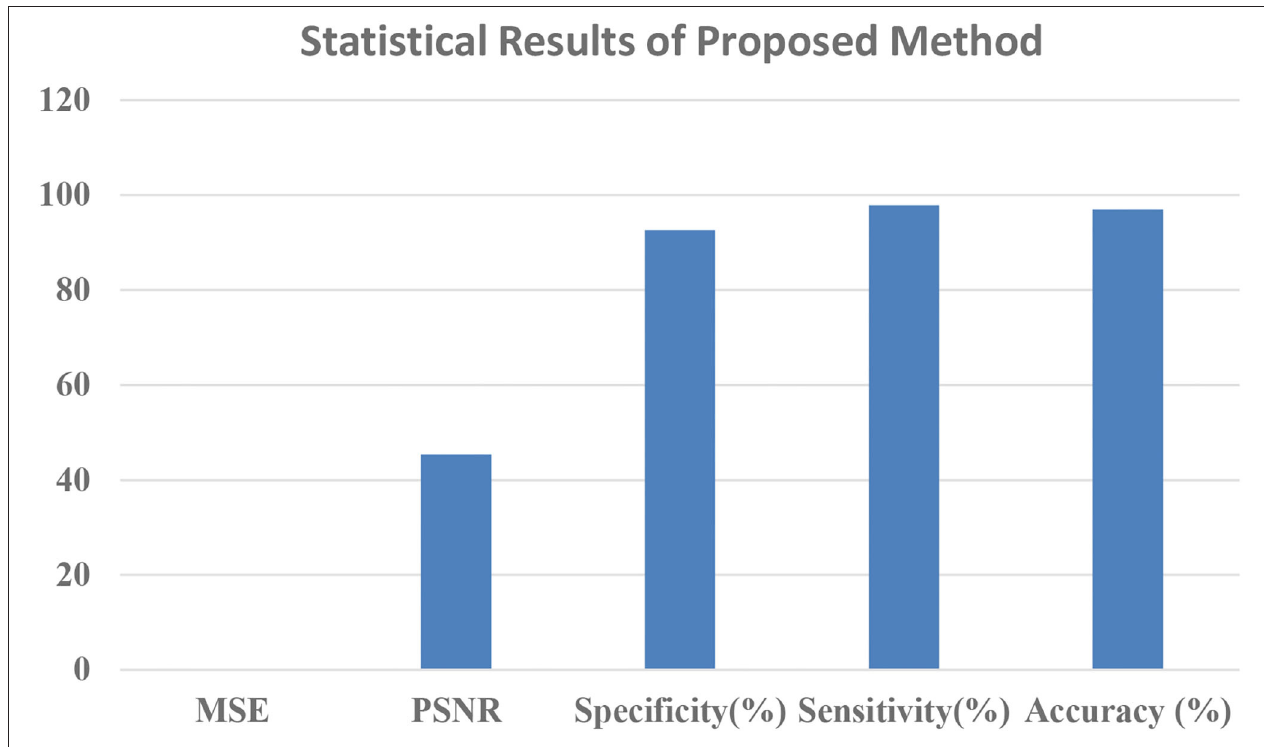
FIGURE 7 | Statistical results graphical representation.